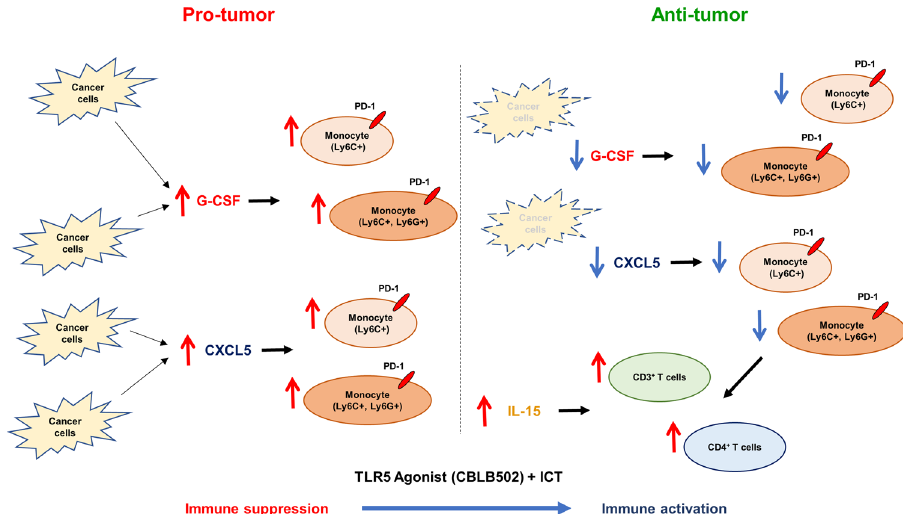
Fig. 7 4T1 tumor immune state switches from immune suppression to immune activation in response to combination treatment with TLR5 agonists and ICT. Tumor microenvironment of BALB/c mice implanted with 4T1 FUGW-FL are highly in fi ltrated by immune suppressor cells favoring pro-tumor microenvironment (left panel). Potent activation of innate immunity through TLR5 agonists in combination with ICT treatments targeting PD-1 and CTLA-4 leads to systemic increases in immune activating cytokine IL-15, and reduction in immune suppressive cytokines G-CSF and CXCL5. Concomitantly, decreases in monocytes (Ly6C + ) and monocytes (Ly6C + , Ly6G + ), accompanied by an increase in CD3 + T cells and CD4 + T cells leads to immune activation and an anti-tumor response (right